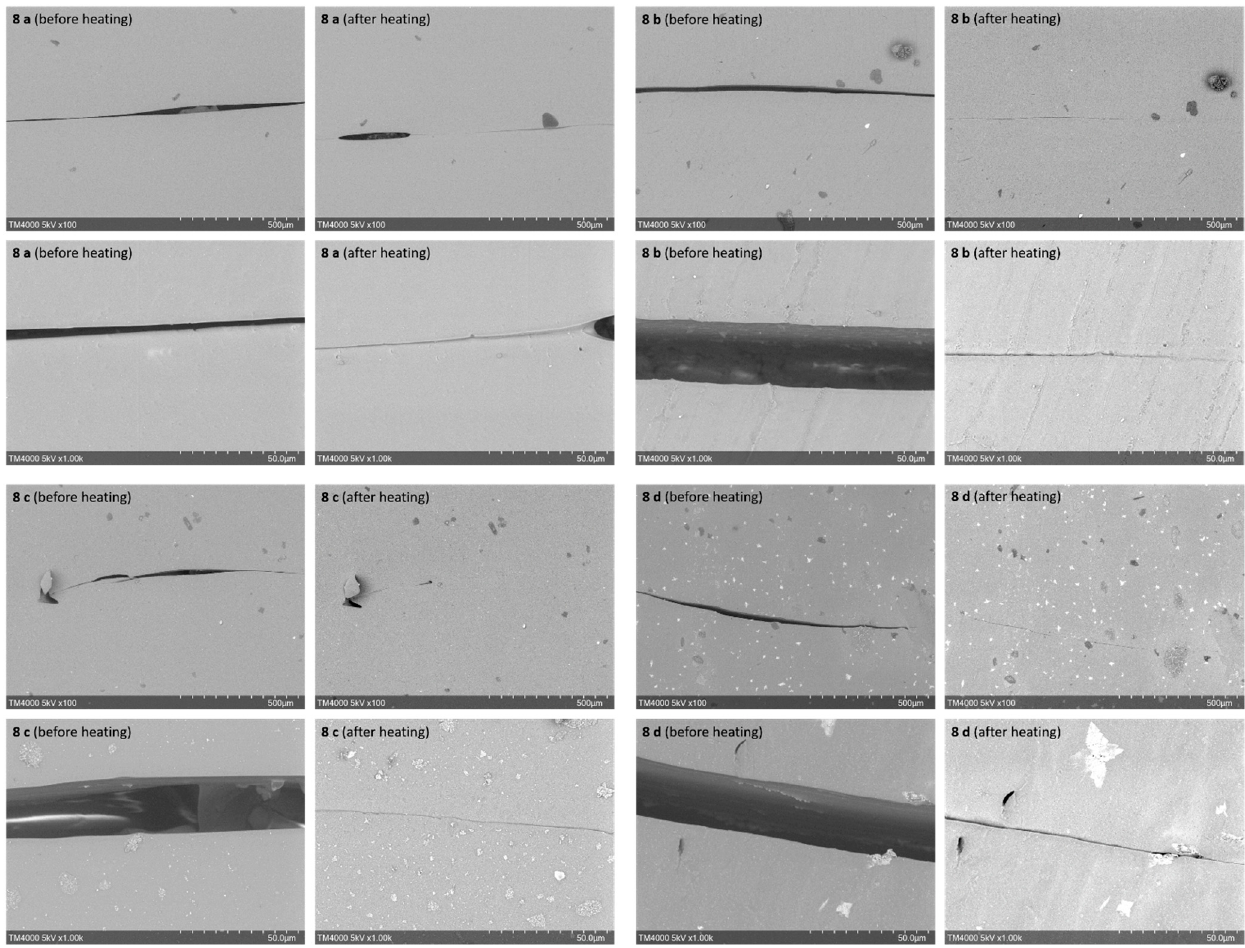
Figure 11. SEM images of polymers 8 a – d at different magnifications before and after